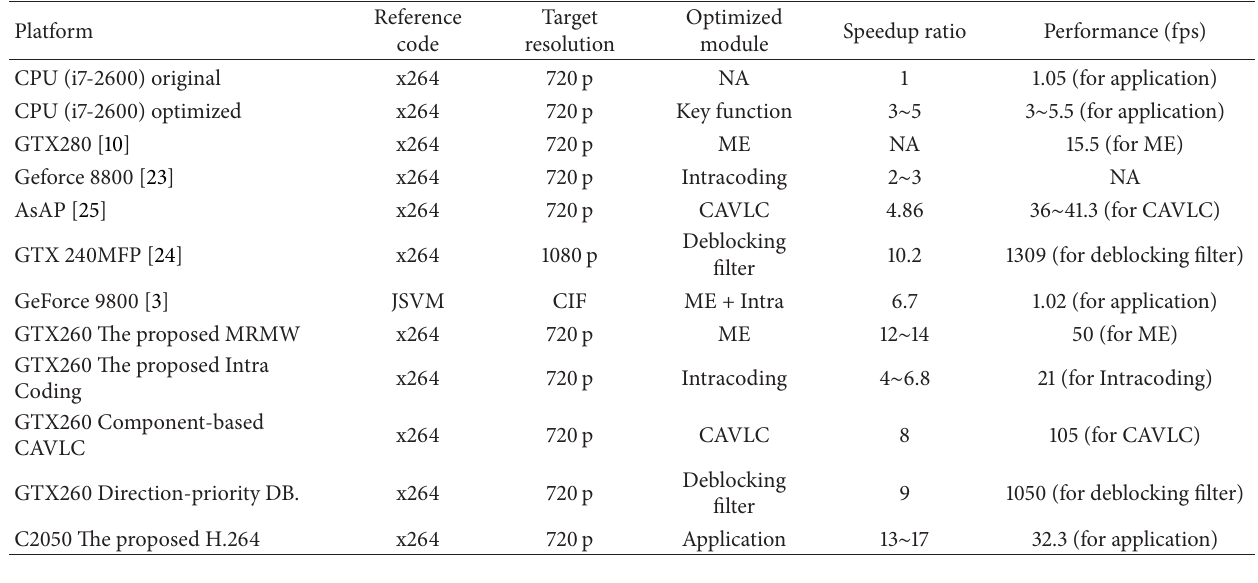
Table 5: Performance comparison between the proposed parallel H.264 encoder and other implementations.